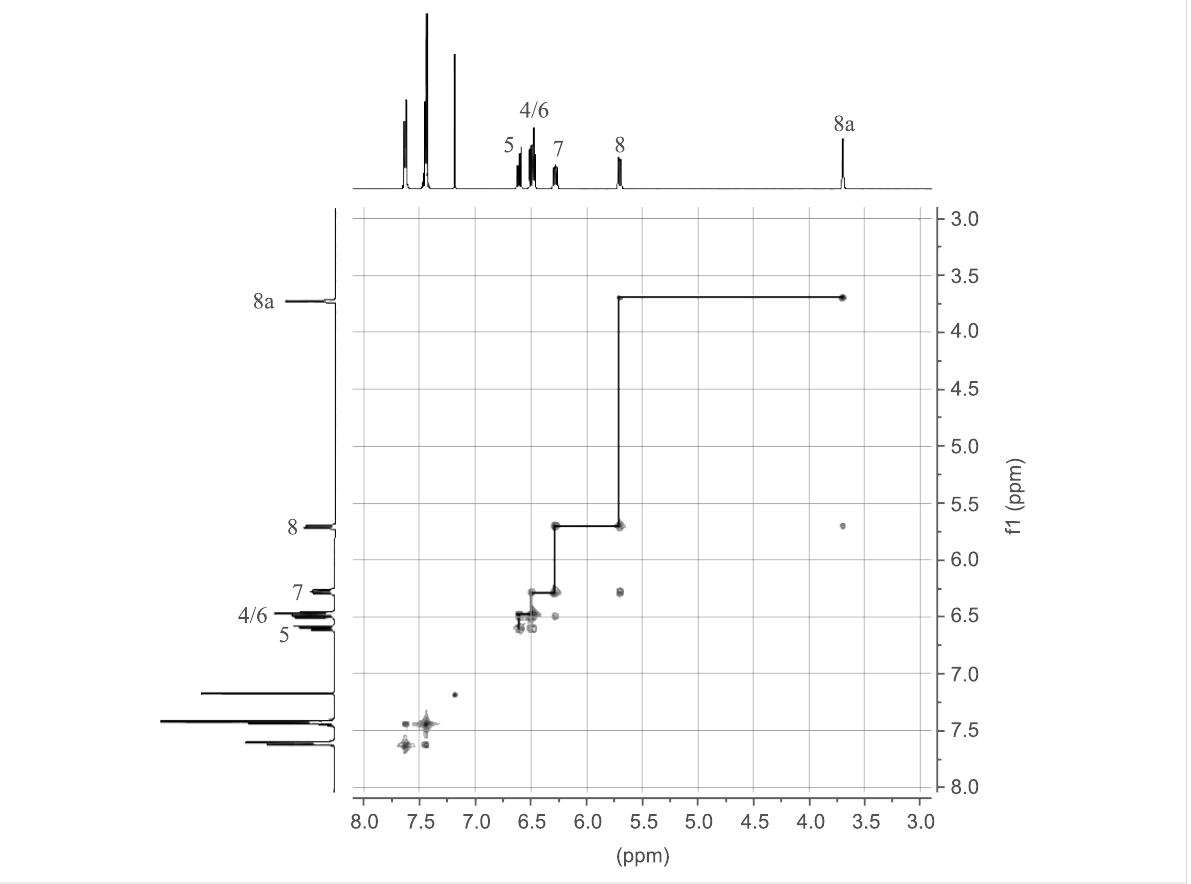
Figure 2: 1 H, 1 H COSY NMR spectrum of DHA 8 (CDCl 3 , 500 MHz). For assignments of DHA signals, see numbering in Figure 1.